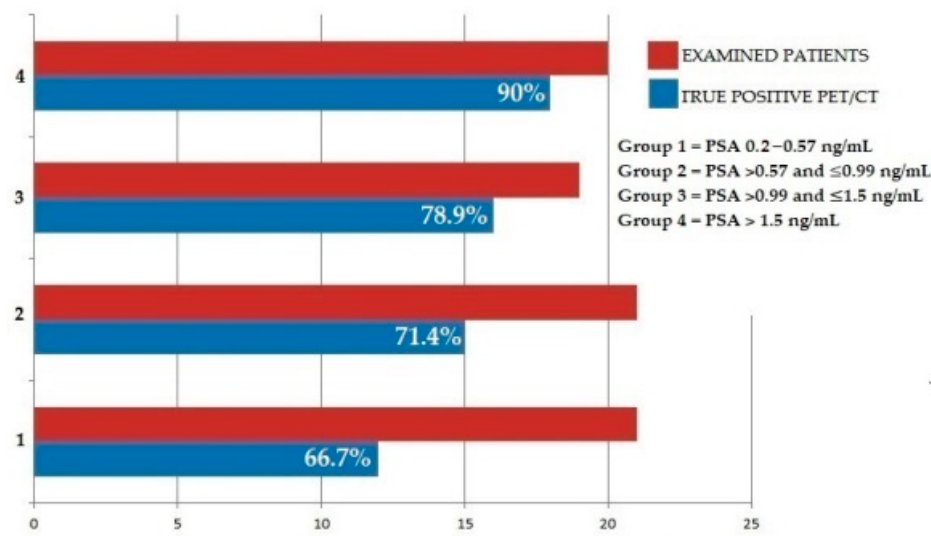
Figure 2. Graphic illustration of PET/CT detection rate in enrolled patients, stratified into 4 groups according to discrete PSA intervals.